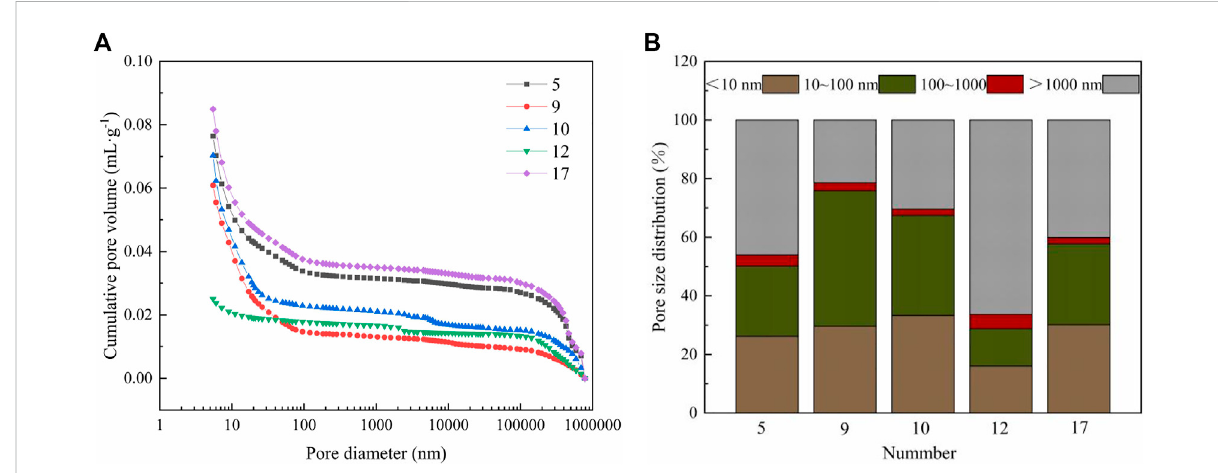
FIGURE 9 MIP spectra of AASM. (A) Cumulative pore volume and (B) Pore size